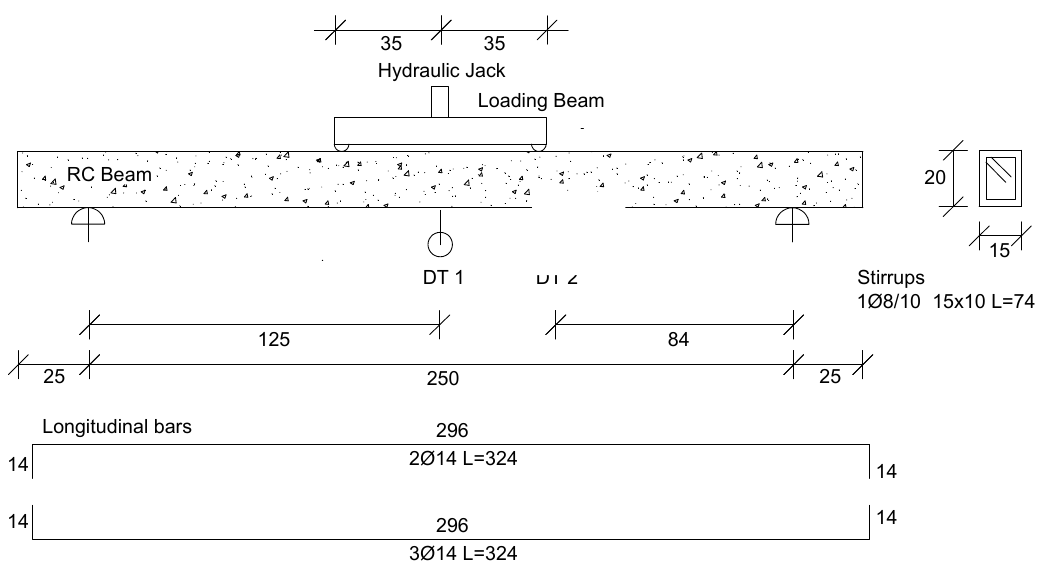
Figure 1. Reinforcement distribution, beam dimensions, and test setup (bar diameters are in mm, all other measures are in cm).